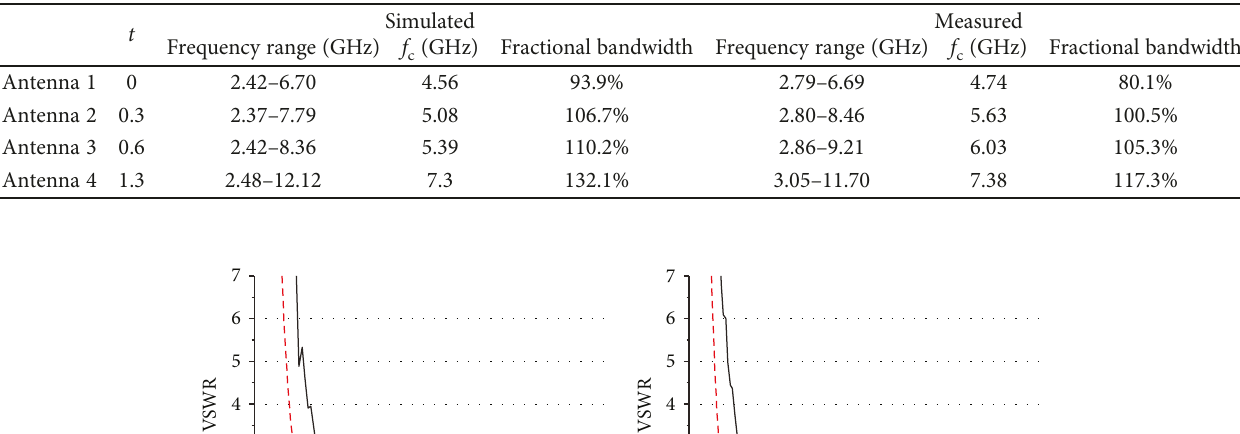
Table 3: Simulated and measured bandwidth comparison.